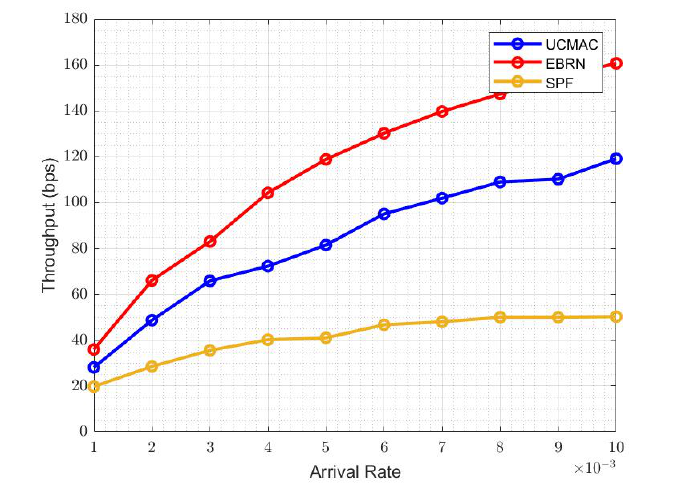
Figure 11. System Throughput.